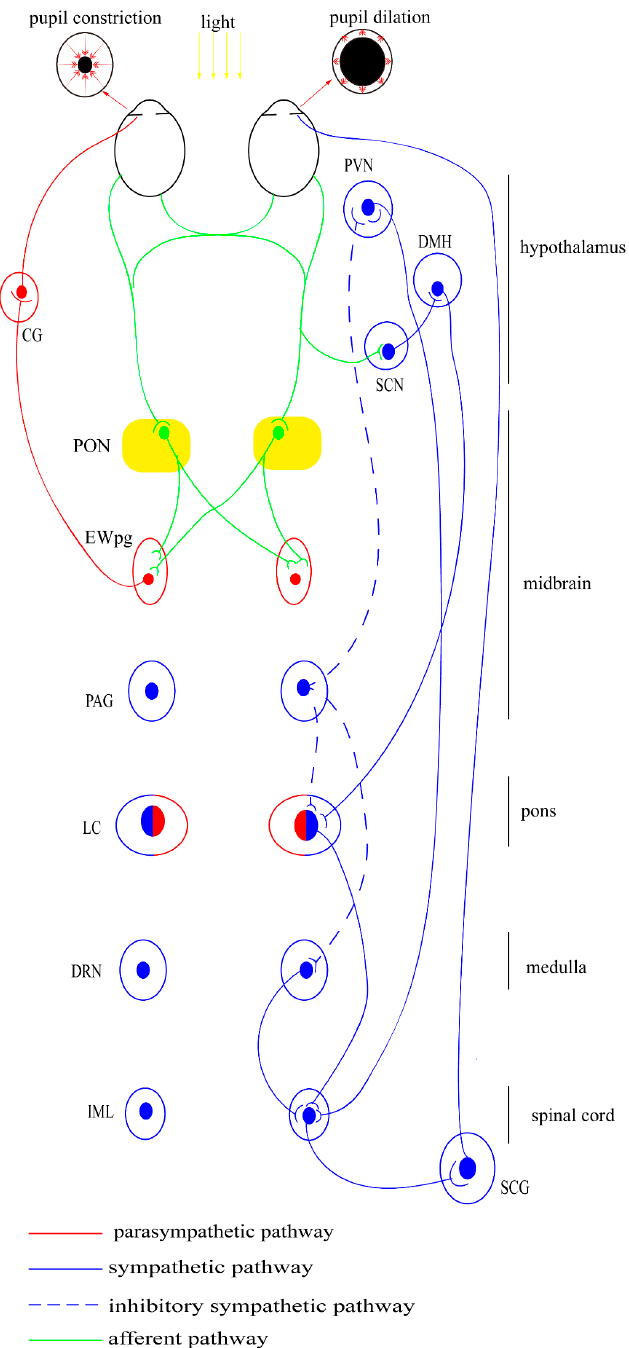
Figure 2. Autonomic pathway of PLR. The encircled areas represent nuclei and ganglia. There are four light-modulated autonomic pathways: (1) parasympathetic (light-stimulated): PON → EW → CG → pupil constriction; (2) sympathetic (light-inhibited): SCN → PVN → IML → SCG → pupil dilation; (3) sympathetic (light-stimulated), SCN → DMH → LC → IML → SCG → pupil dilation; (4) sympathetic (light-inhibited): pretectum → PAG → sympathetic premotor nuclei (PVN, LC, DR) → IML → SCG → pupil dilation; CG— ciliary ganglion; DMH—dorsomedial hypothalamus; DRN—dorsal raphe nucleus; EWpg—Edinger- Westphal nucleus; IML—intermediolateral column; LC—locus coeruleus; oc—optic chiasm; PAG— periaqueductal gray autonomic ganglia; PON—pretectal olivary nucleus; PVN—paraventricular nucleus; SCG—superior cervical ganglion; SCN—suprachiasmatic